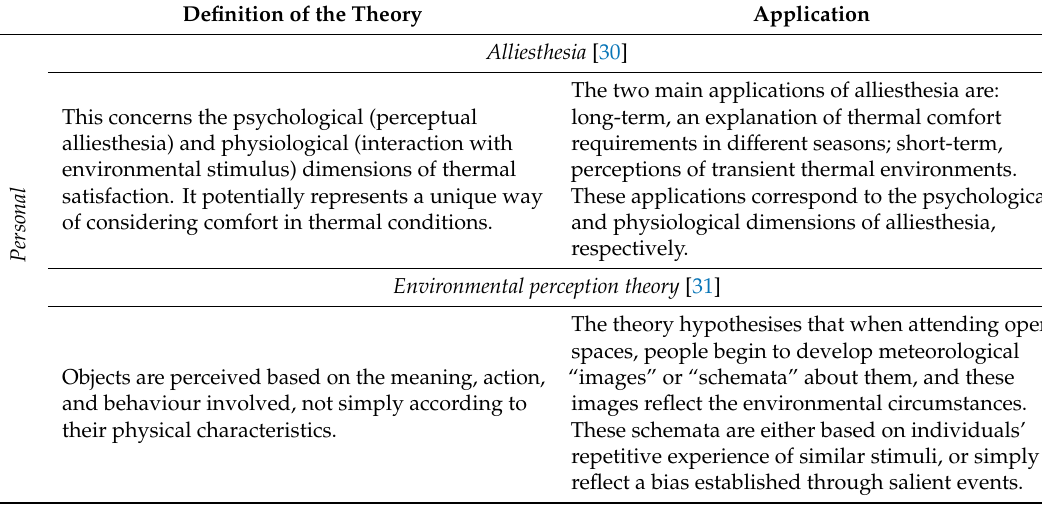
Table 1. Summary of indoor thermal comfort studies as a theoretical framework